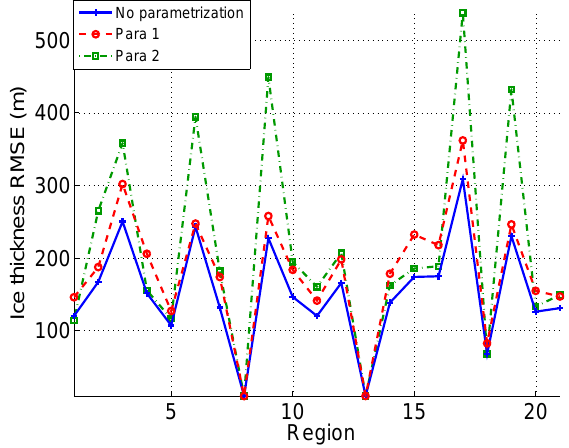
Figure 5. Ratio of the SG model over ISSM total ice volume for six different regions in the Rockies as a function of hypsometric bins. The simulations were run until steady state with a constant sea level temperature of 0 ◦ C and a desertification effect factor of 0.5. The steady state ice thicknesses, velocities and slopes from the ISSM and the SG model (using 10 hypsometric bins) are presented in Fig. S3 in the Supplement.